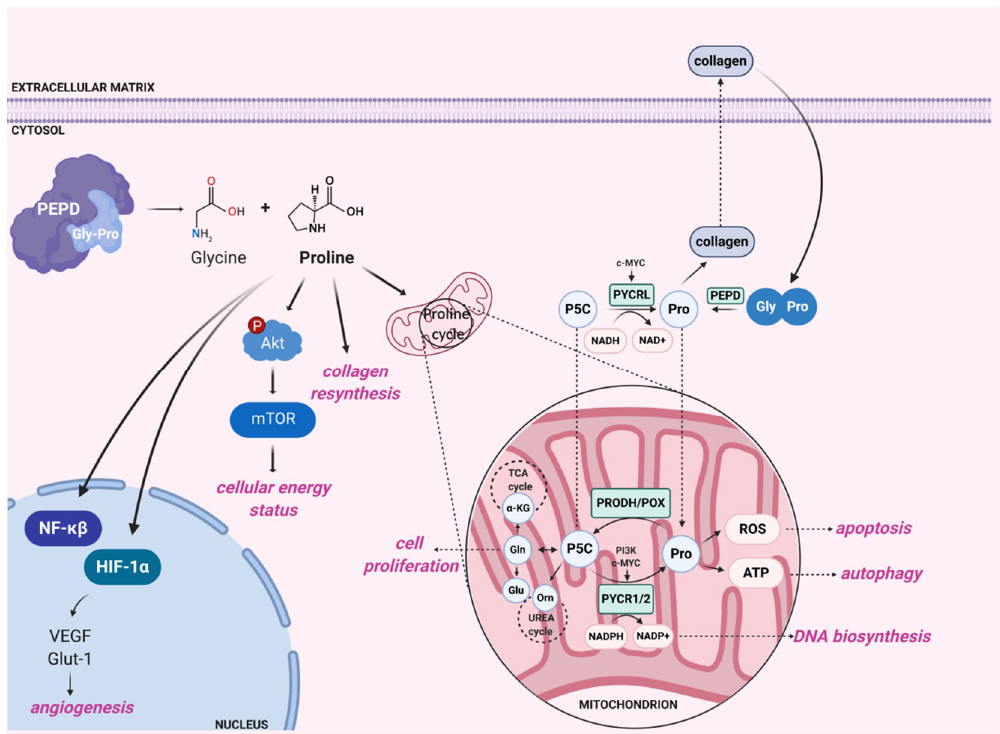
Figure 3. Enzymatic activity of prolidase affects various cellular processes. Prolidase supplies substrates for collagen resynthesis. Proline, the product of prolidase activity, modulates intracellular energetic status via Akt/mTOR pathway, inhibits HIF-1α degradation, and mediates in proline cycle,